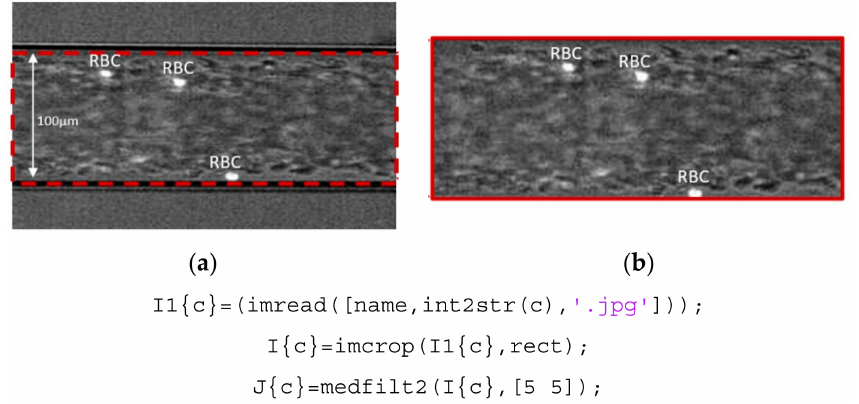
Figure 3. Image sequences imported ( a ) and respective region of interest cropped ( b